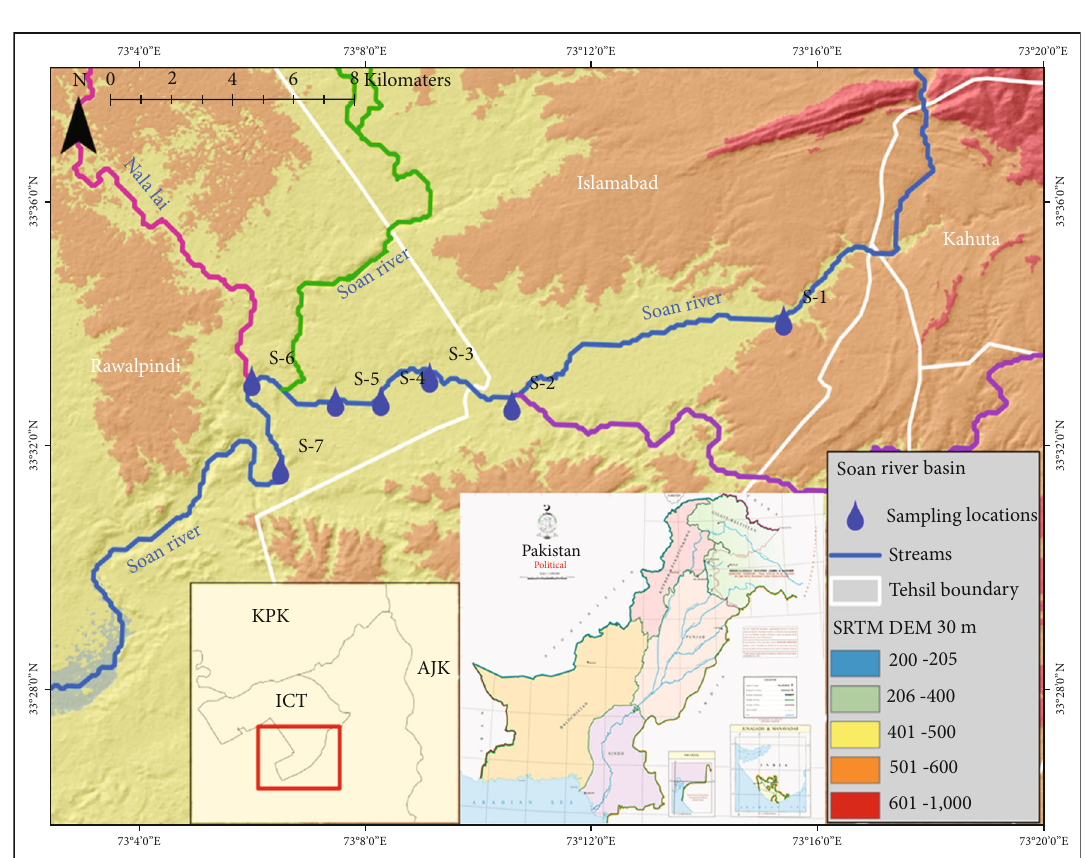
Figure 1: Map of the study area showing water quality monitoring